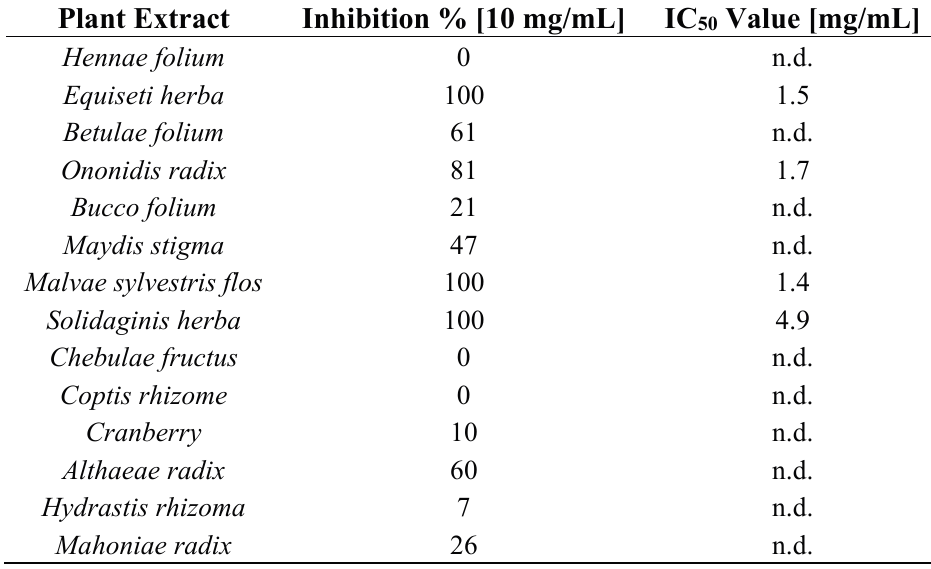
Table 2. Effect of plant extracts on the activity of surface displayed